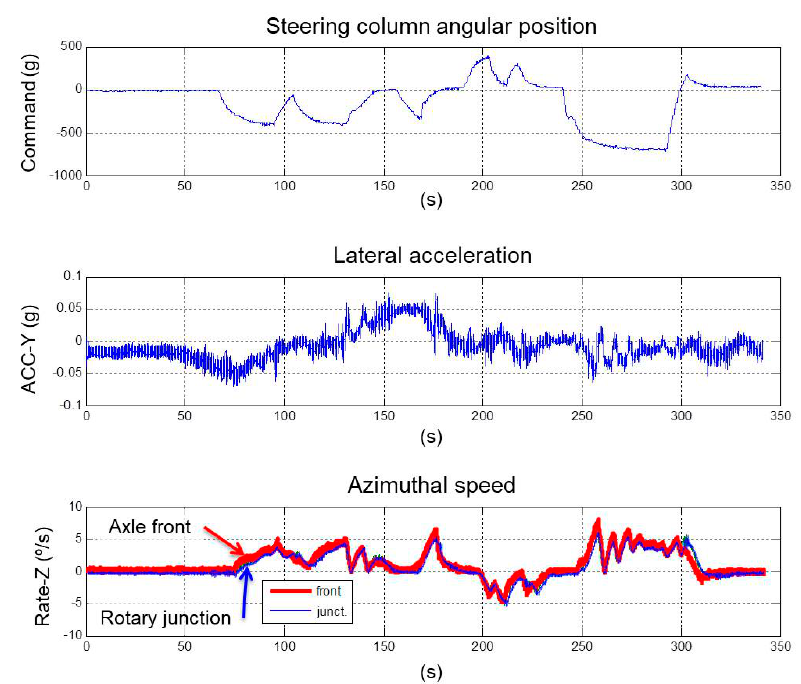
Figure 15. Comparison among steering command, lateral acceleration and angular rate in the z -axis during the tracking of the trajectory.